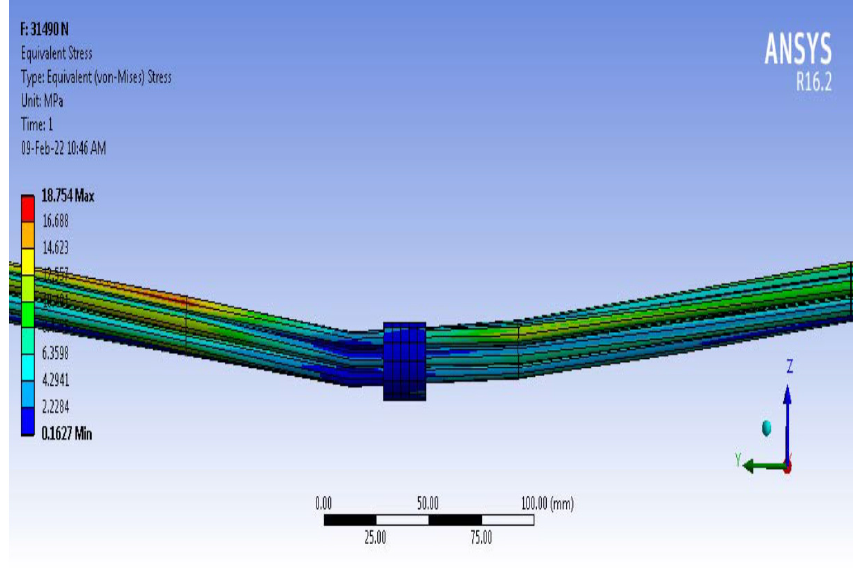
Figure 15. Phase II Equivalent Stress distributions on steel wire rope.